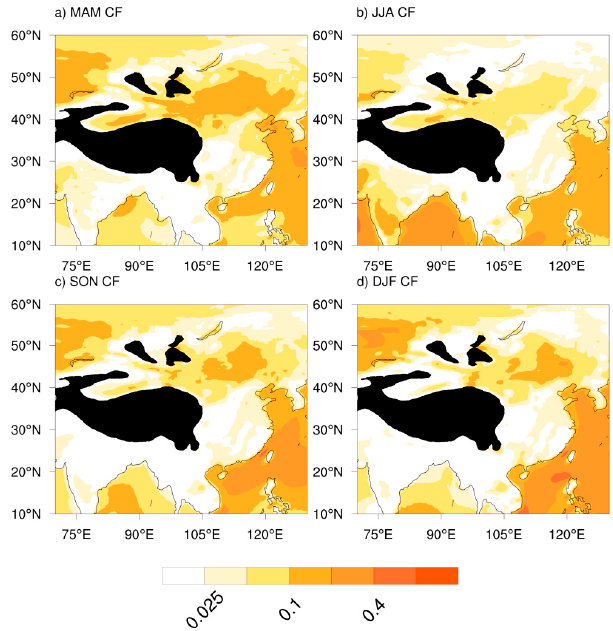
Figure 5. Seasonal averages of wind power capacity factor in ( a ) spring MAM, ( b ) summer JJA, ( c ) autumn SON, and ( d ) winter DJF.